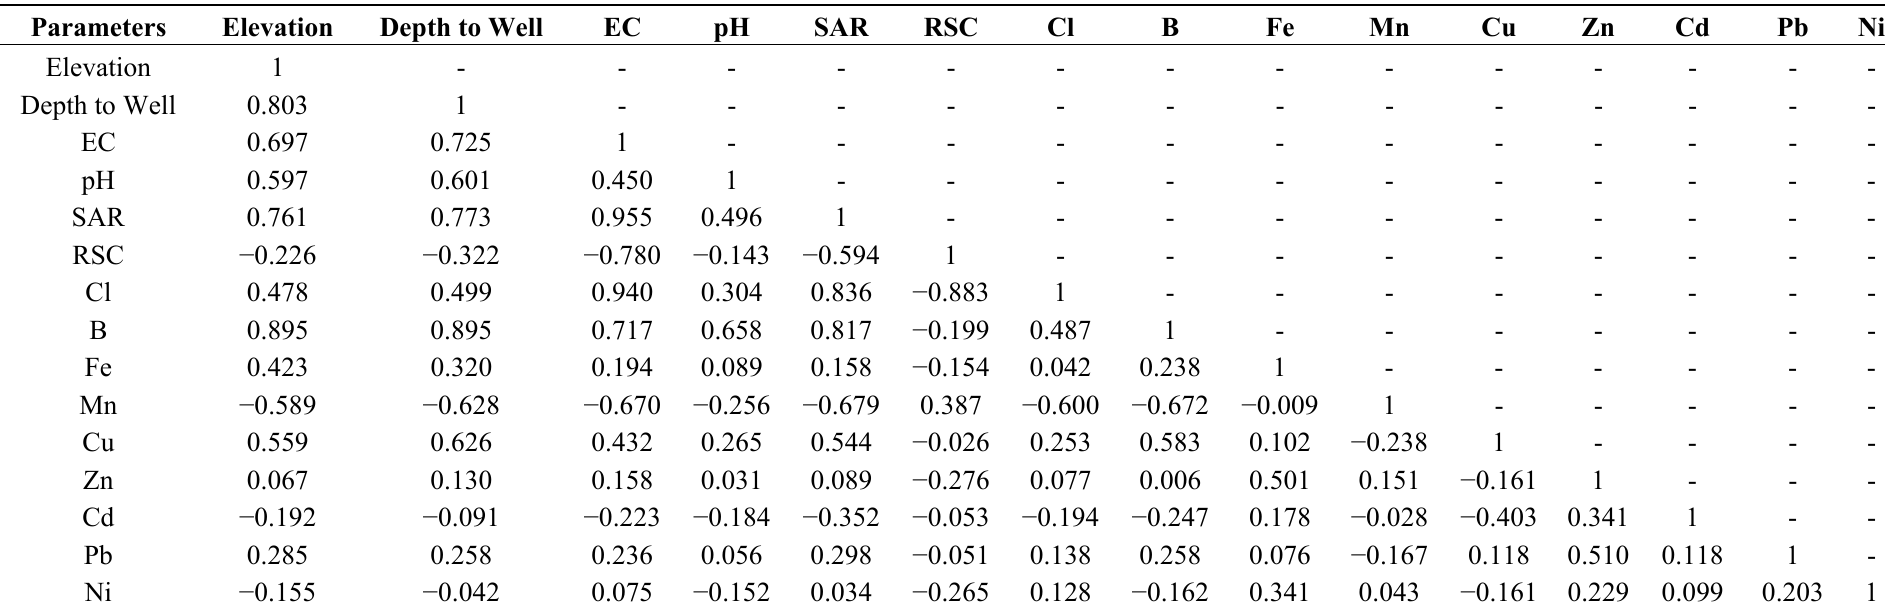
Table 4. Correlation matrix for the analyzed